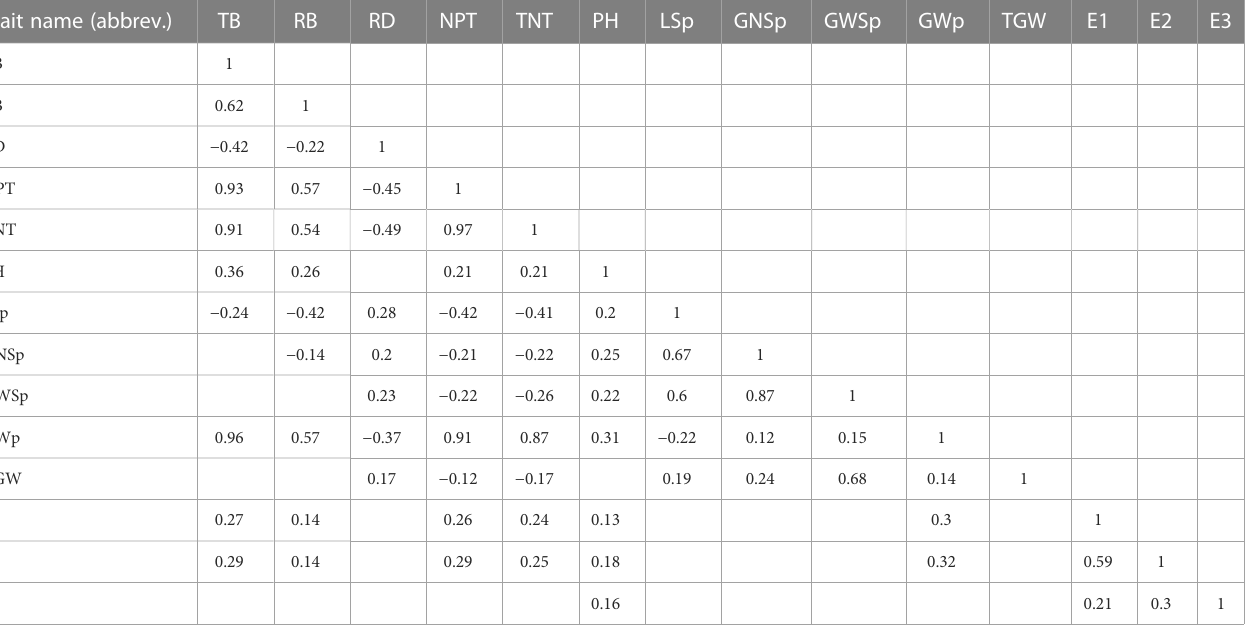
side (positive values of PC1), and evenly distributed groups of breeding lines overlapped with the subgroups of cultivars. PCoA separated some breeding lines (offspring with parents) from the rest of the genotypes. As shown in Supplementary Figure 1, the dendrogram obtained by hierarchical clustering based on the kinship matrix con fi rmed the results of PCoA: the barley breeding lines and cultivars that were used as parents/donors at some stage of